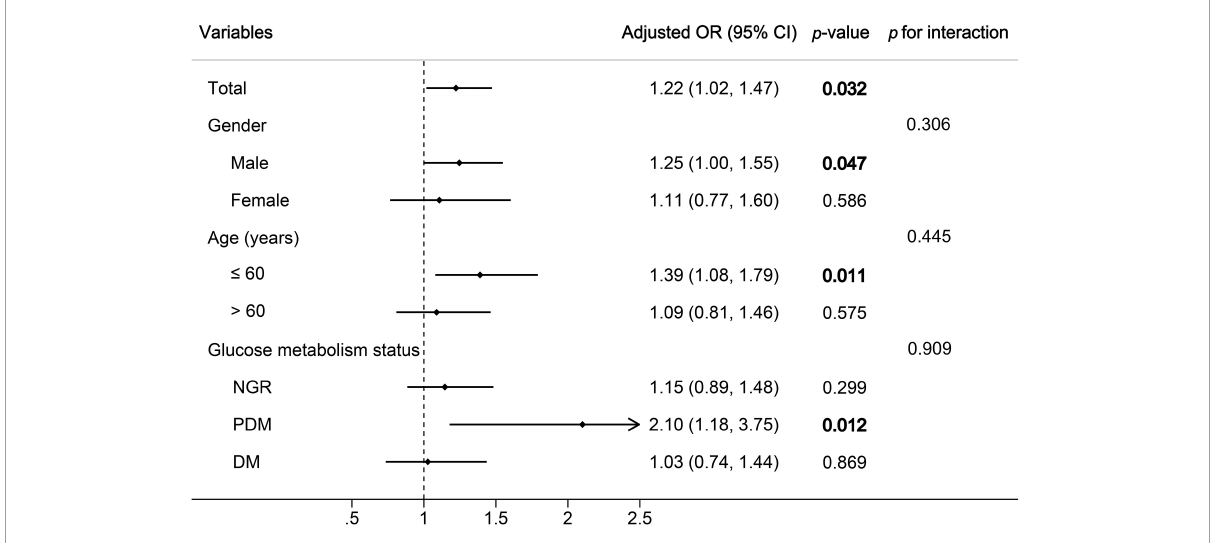
FIGURE3 Subgroup and interaction analyses between the METS-IR (Per SD) and high GS across various subgroups. OR, odds ratio; CI, confidence interval; GS, Gensini score; NGR, normal glucose regulation; PDM, prediabetes mellitus; DM, diabetes mellitus. p -values in bold are < 0.05.